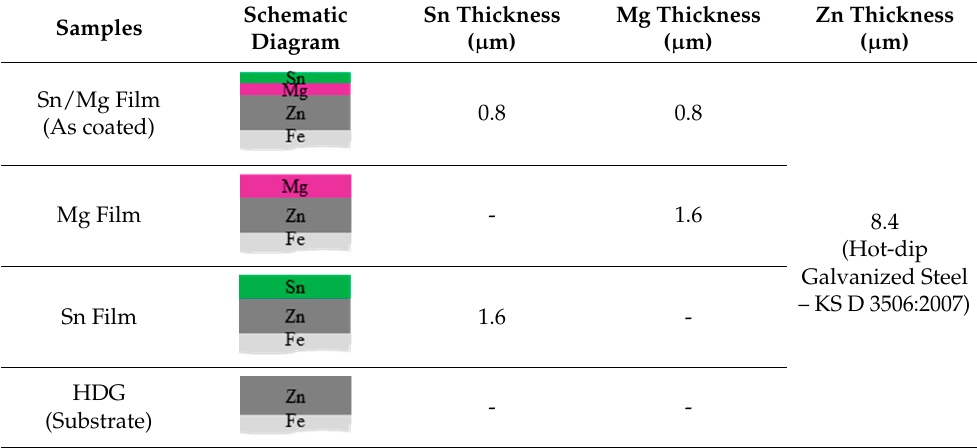
Table 1. Information about the samples in this study: Sn/Mg film; Mg film; Sn film; and substrate.